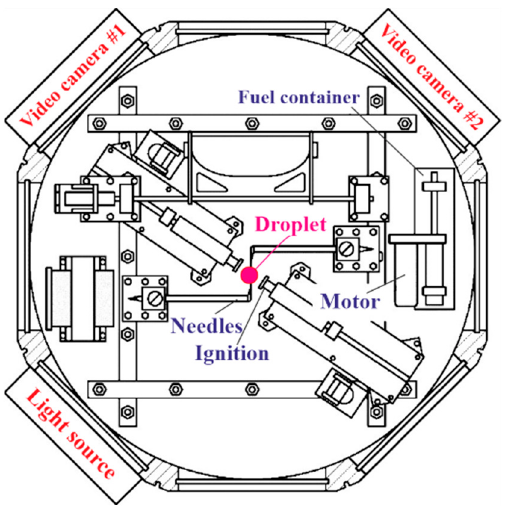
Figure 1. Combustion chamber, auxiliary devices, and recording equipment used in the Cool Flame Investigation—Zarevo space experiment at the ISS.